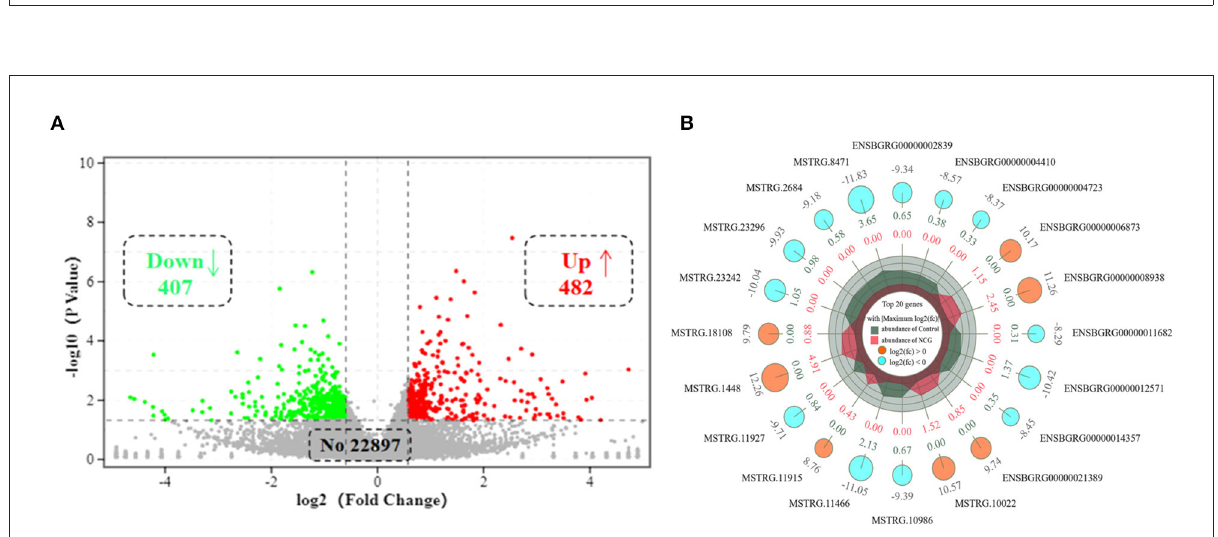
FIGURE2 Volcano plot of (A) and top 20 (B) differentially expressed genes (DEGs) in yak ovaries for the Control and NCG groups.